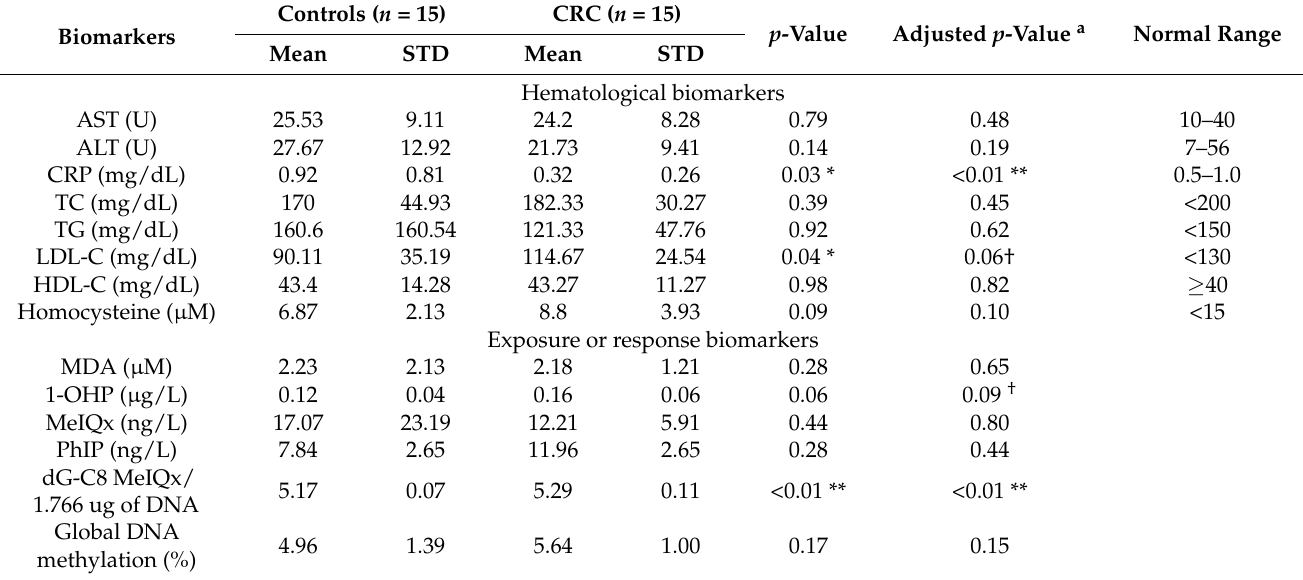
Table 2. Comparison of biomarkers between controls and